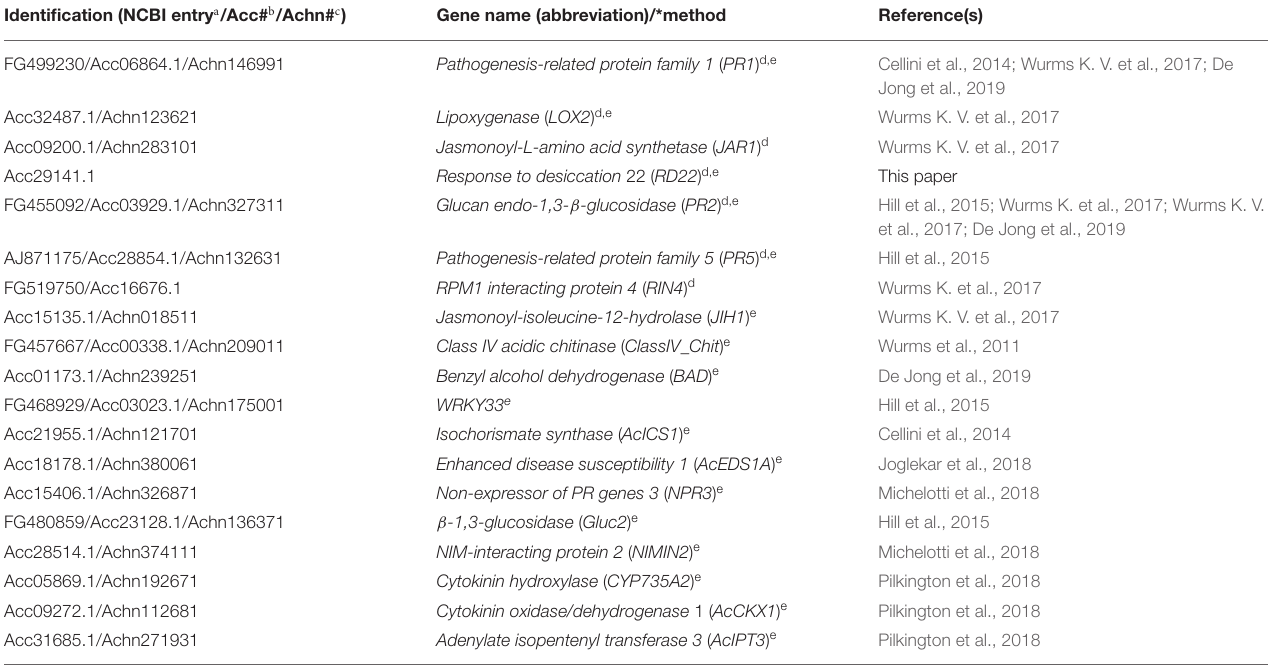
TABLE 2 | Genes of interest for analysis of defence expression by quantitative polymerase chain reaction (qPCR) and by PlexSet ® NanoString. Identification (NCBI entry a /Acc# b /Achn# c